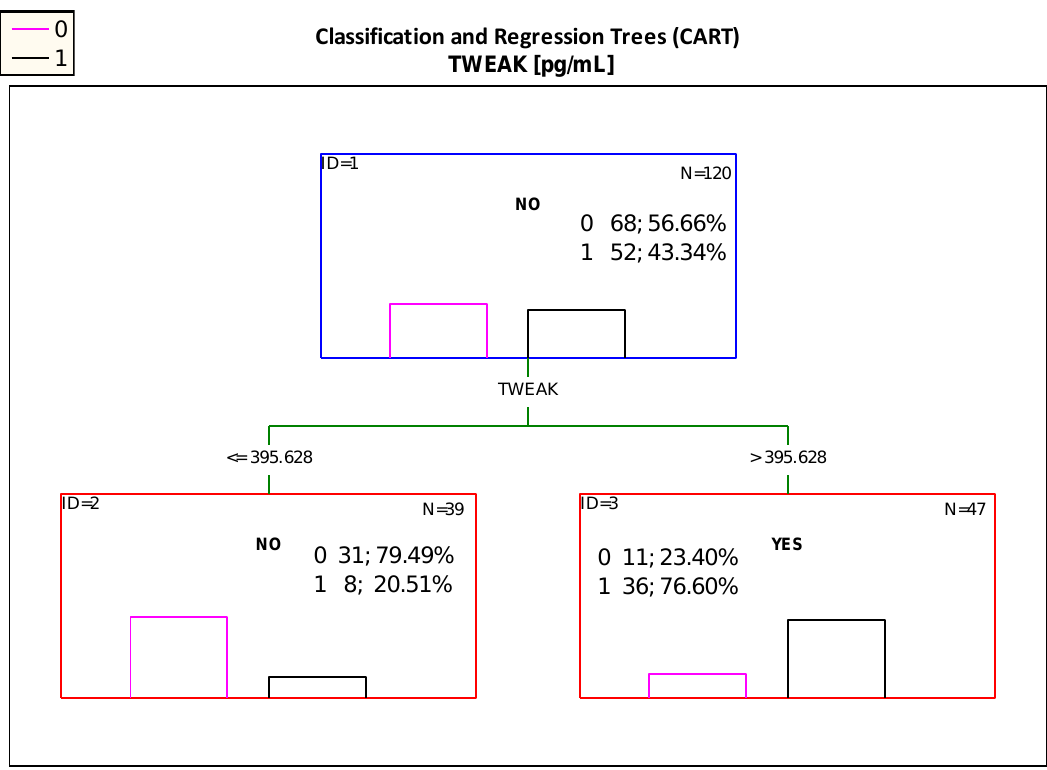
Figure 3. Classification tree for impaired renal function (albuminuria and/or decreased eGFR < 90 mL/min/1.73 m 2 and/or hypertension) created by analysis taking into account the TWEAK serum concentration. Figure legend: 0—normal kidney function (pink column), 1—impaired renal function (albuminuria and/ or decreased eGFR < 90 mL/min/1.73 m 2 and/ or hypertension) (black